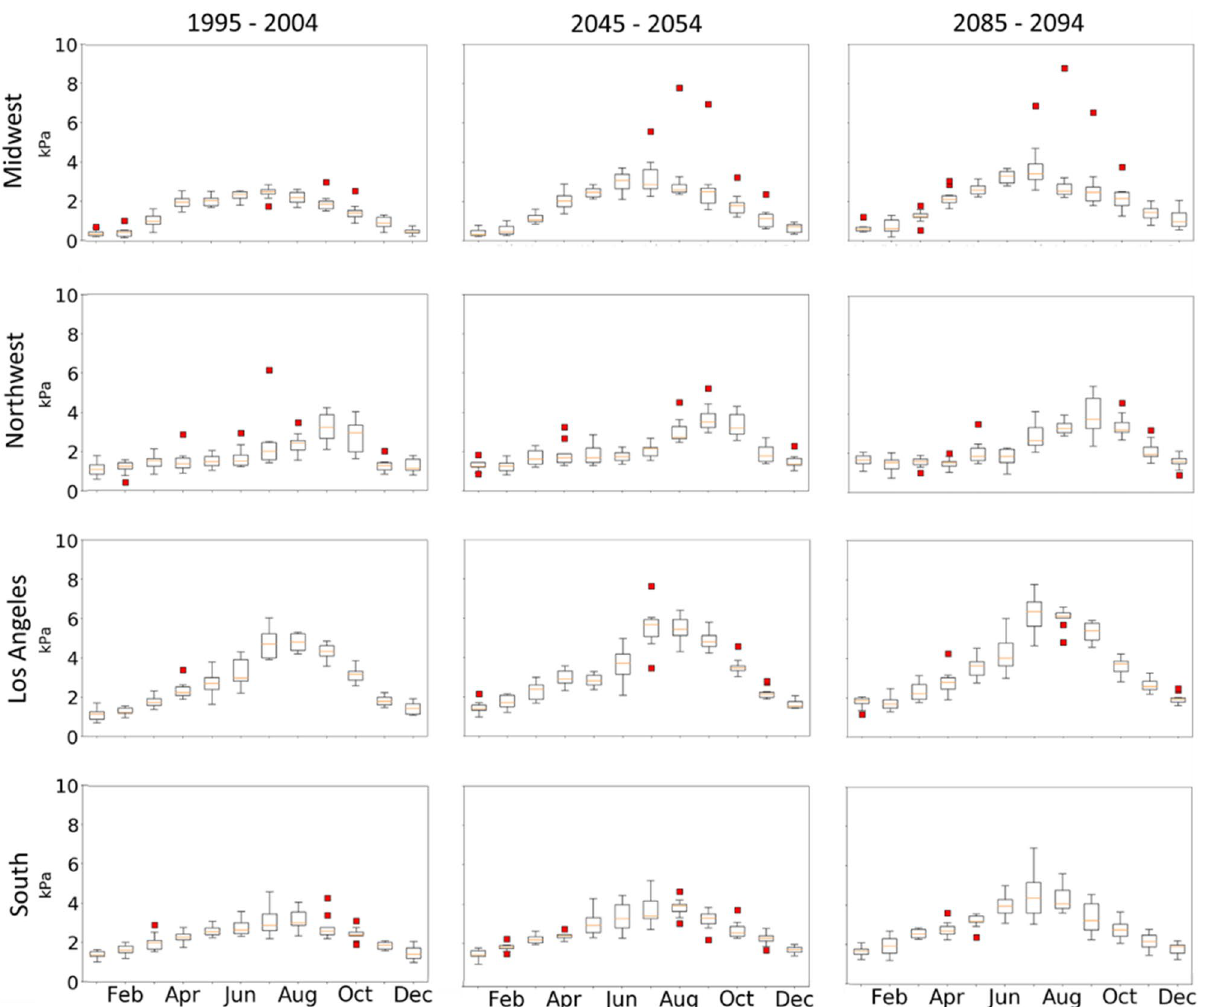
Figure 8. CCSM_WRF VPD boxplots of monthly maximum with outliers (red squares) for Western Oregon (43.06° N, 123.57° W; Northwest), Northern Iowa (43.38° N, 92.73° W; Midwest), Central Alabama (32.11 N°, 86.55 W°; South), and Southern California (34.14 N°, 118.17 W°; LA) for each decadal